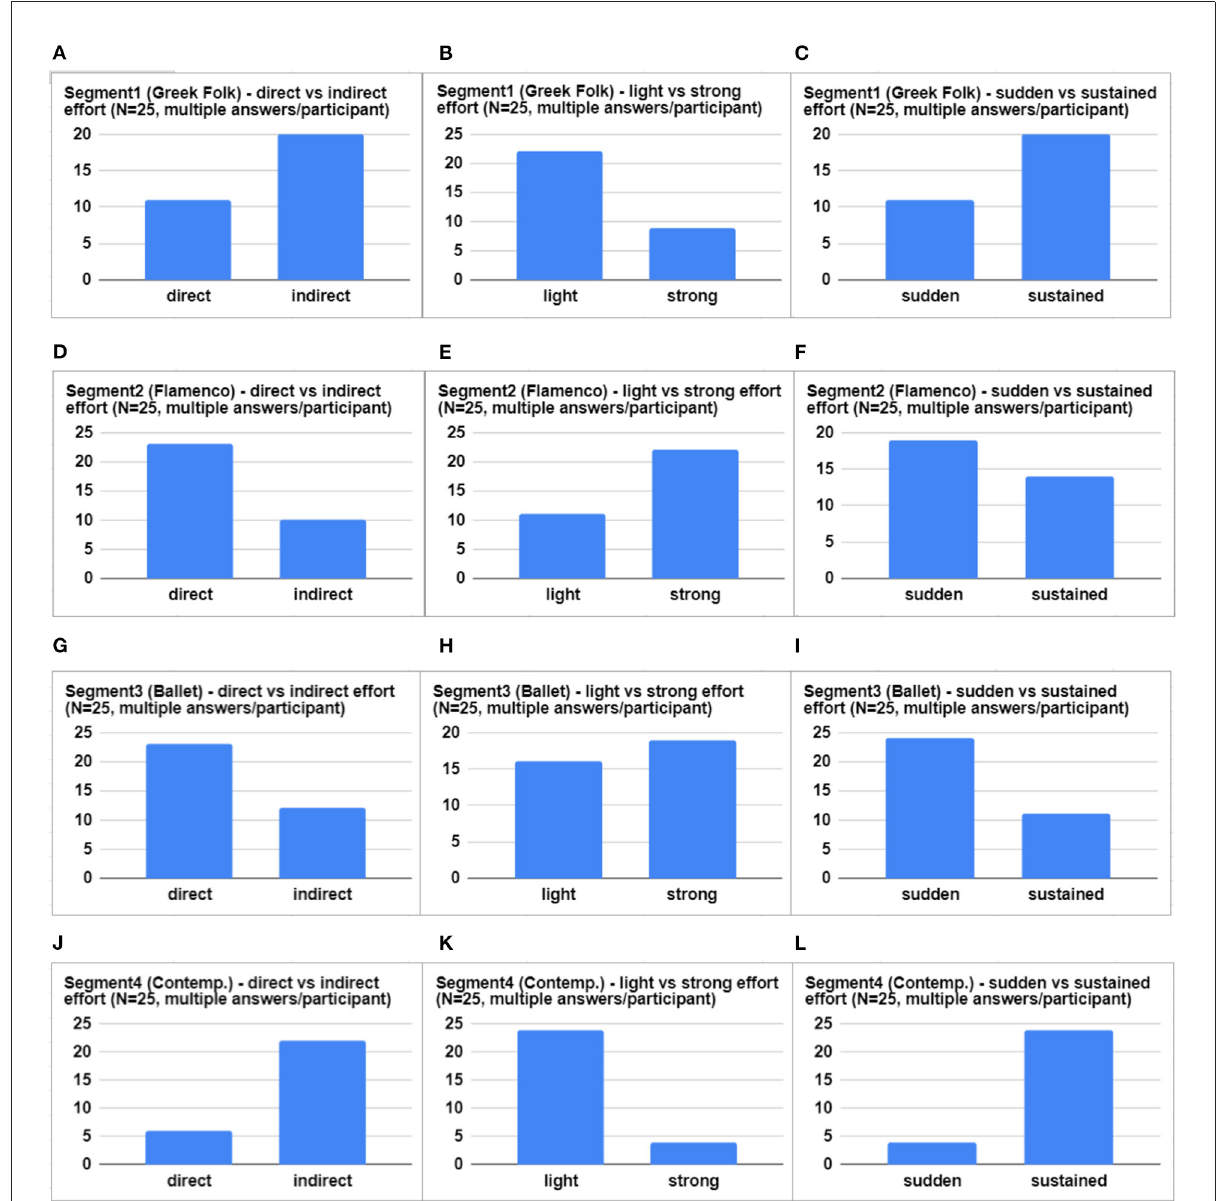
FIGURE14 Comparisons of participants’ Laban Effort annotations for each motion factor. Panel (A) shows the annotations of the motion factor of Space for Segment1 (Greek folk), panel (B) shows the annotations of the motion factor of Weight for Segment1 (Greek folk), panel (C) shows the annotations of the motion factor of Time for Segment1 (Greek folk), (D) shows the annotations of the motion factor of Space for Segment2 (Flamenco), panel (E) shows the annotations of the motion factor of Weight for Segment2 (Flamenco), panel (F) shows the annotations of the motion factor of Time for Segment2 (Flamenco), panel (G) shows the annotations of the motion factor of Space for Segment3 (Ballet), panel (H) shows the annotations of the motion factor of Weight for Segment3 (Ballet), panel (I) shows the annotations of the motion factor of Time for Segment3 (Ballet), panel (J) shows the annotations of the motion factor of Space for Segment4 (Contemporary), panel (K) shows the annotations of the motion factor of Weight for Segment4 (Contemporary) and panel (L) shows the annotations of the motion factor of Time for Segment4